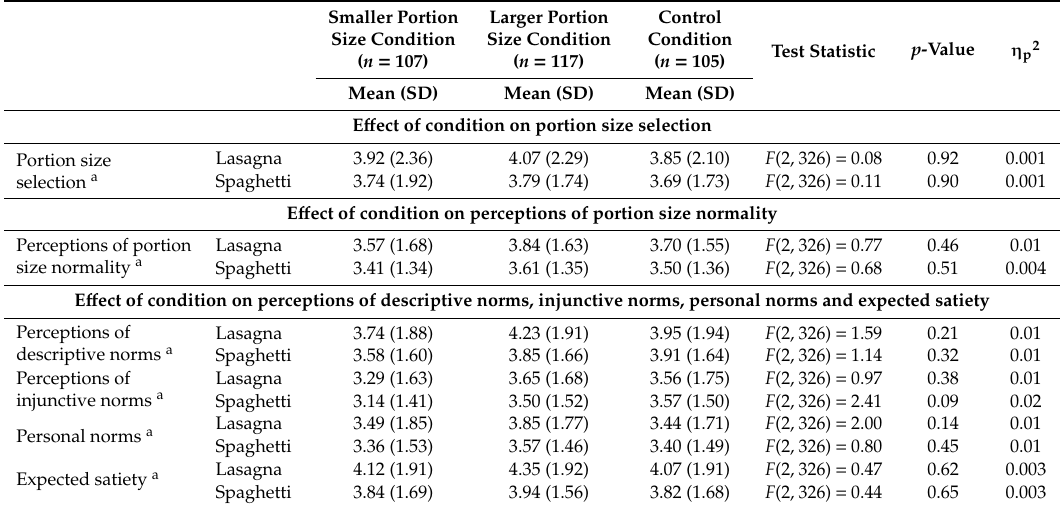
Table 3. Portion size selection and portion size evaluations per condition on day 2 ( n =